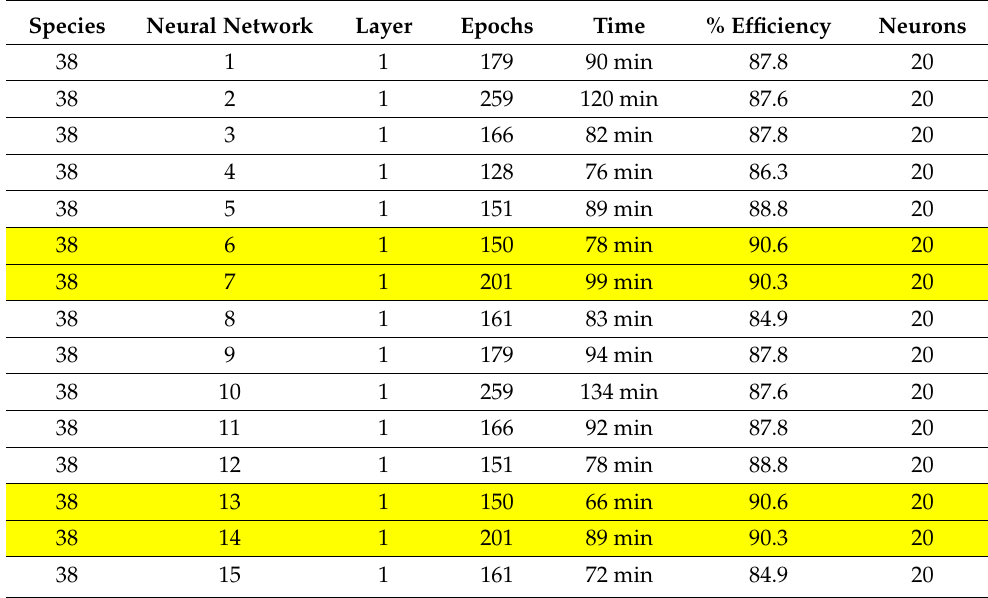
Table 3. Second experiment. Fifteen runs of the neural network with 37 species, 1 control group (38 “species”), and 20 neurons in the hidden